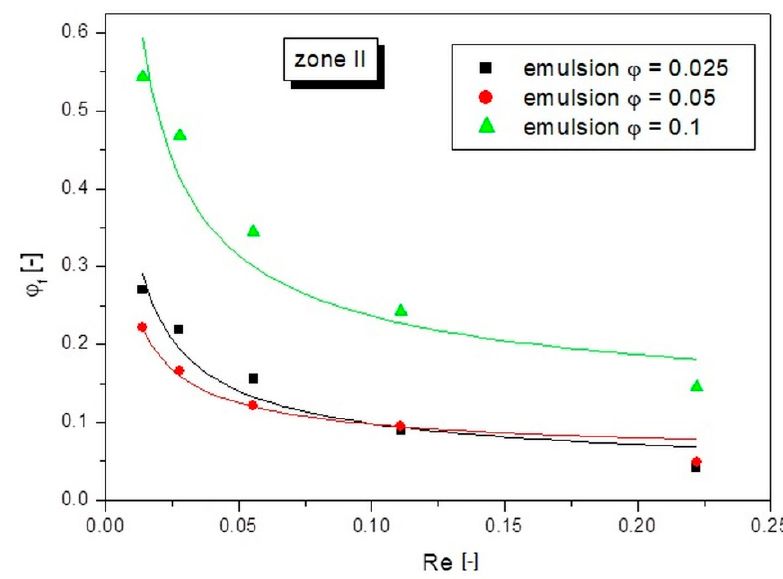
Figure 8. Dependences of the actual concentration on the Re number of the liquid for different emulsion concentrations in zone II.